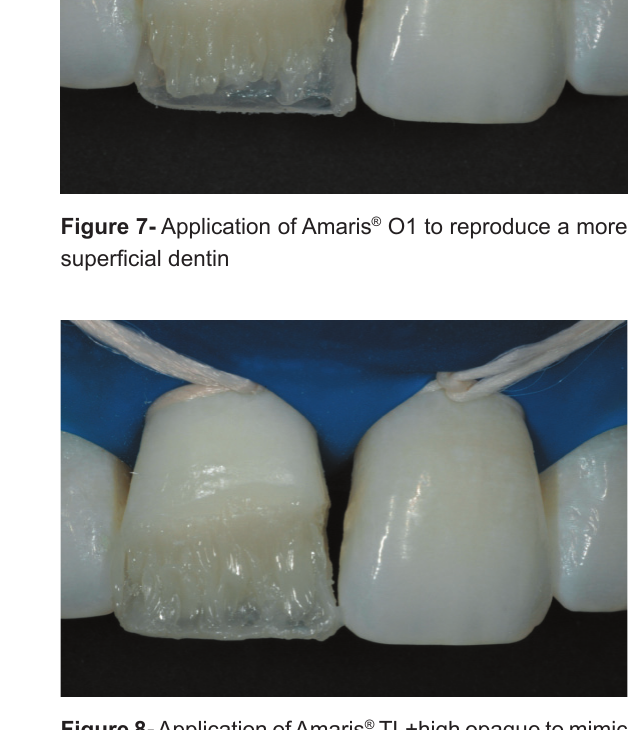
Figure 8- Application of Amaris ® TL+high opaque to